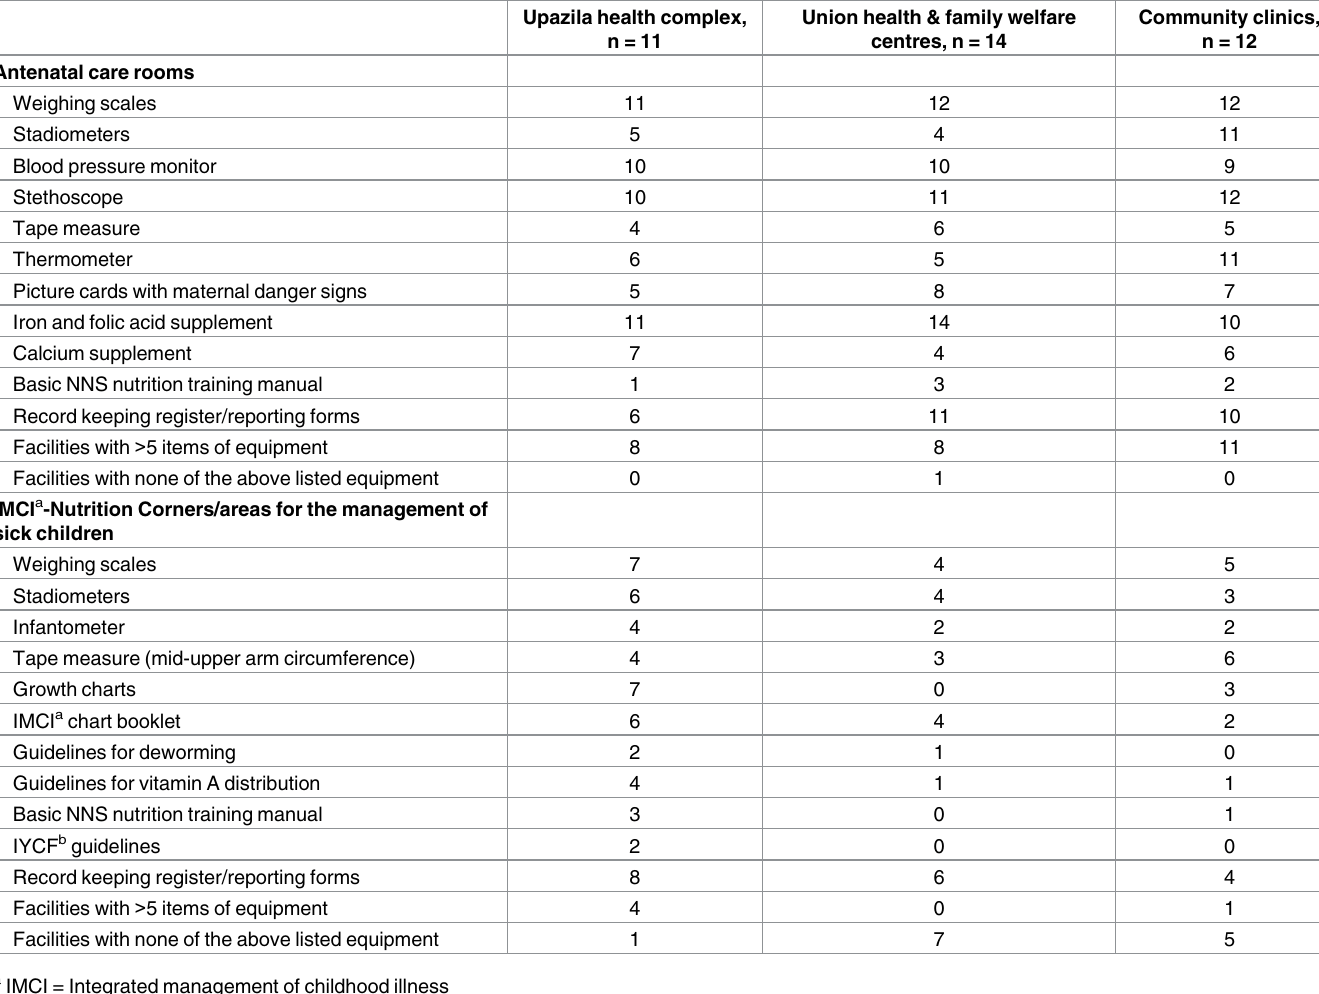
Table 2. Structural readiness of health facilities—Availability of equipment, supplements, guidelines and record keeping